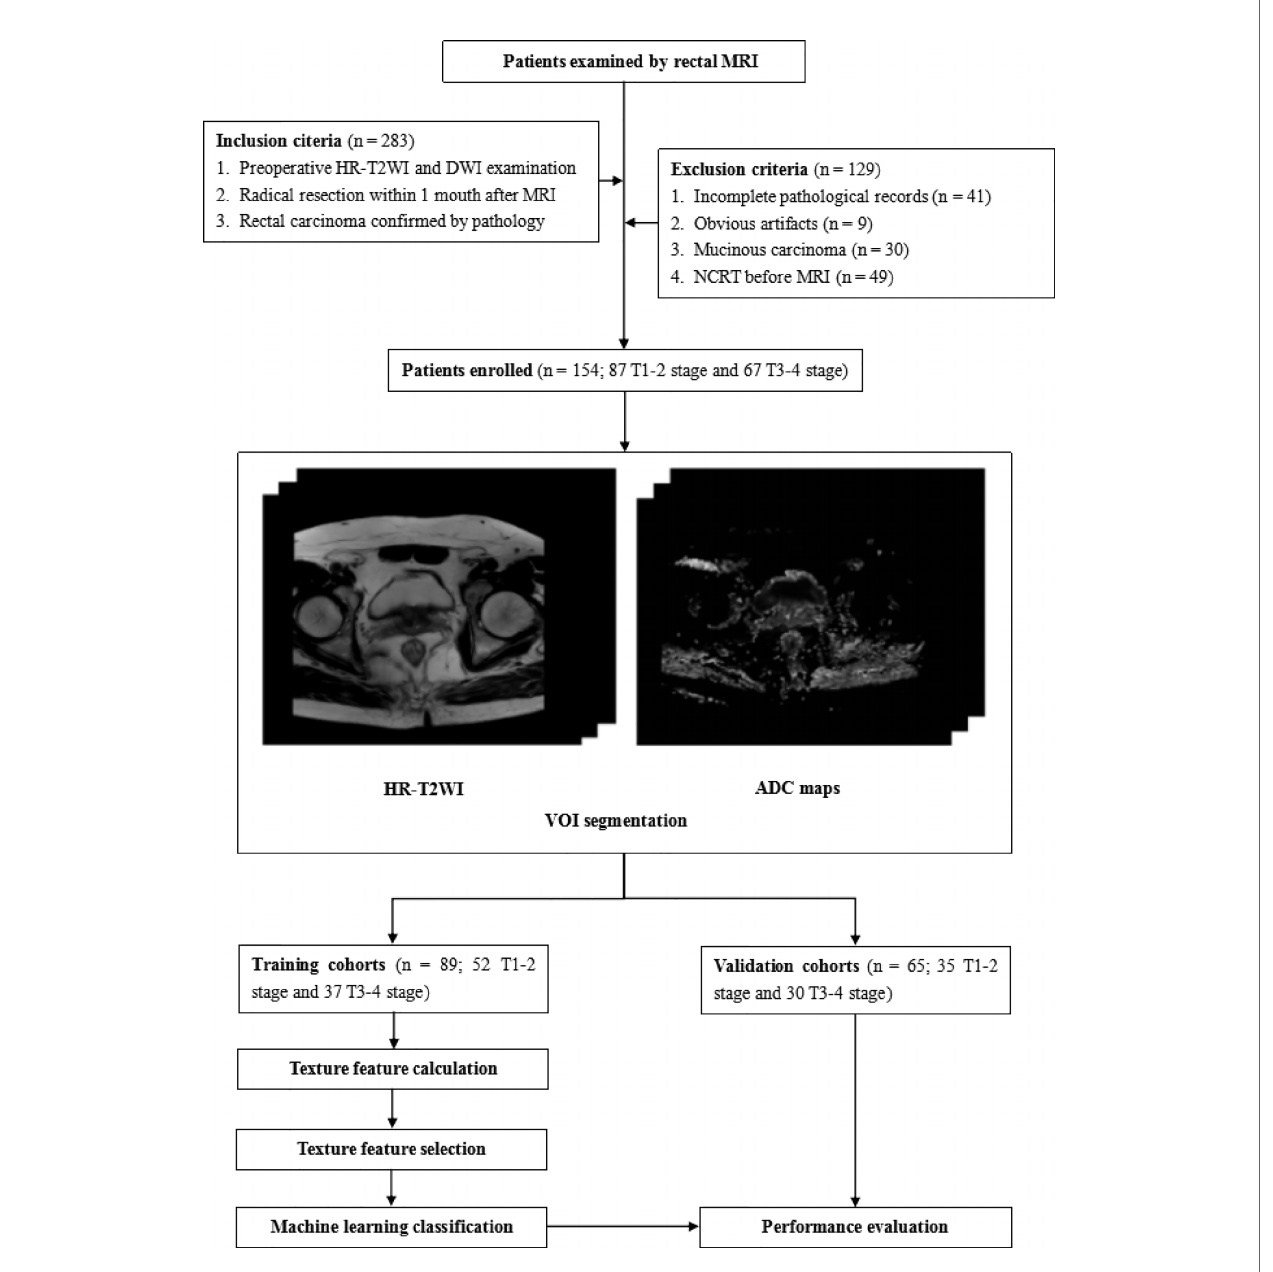
FIGURE 1 | The fl ow chart of this research. VOI, volume of